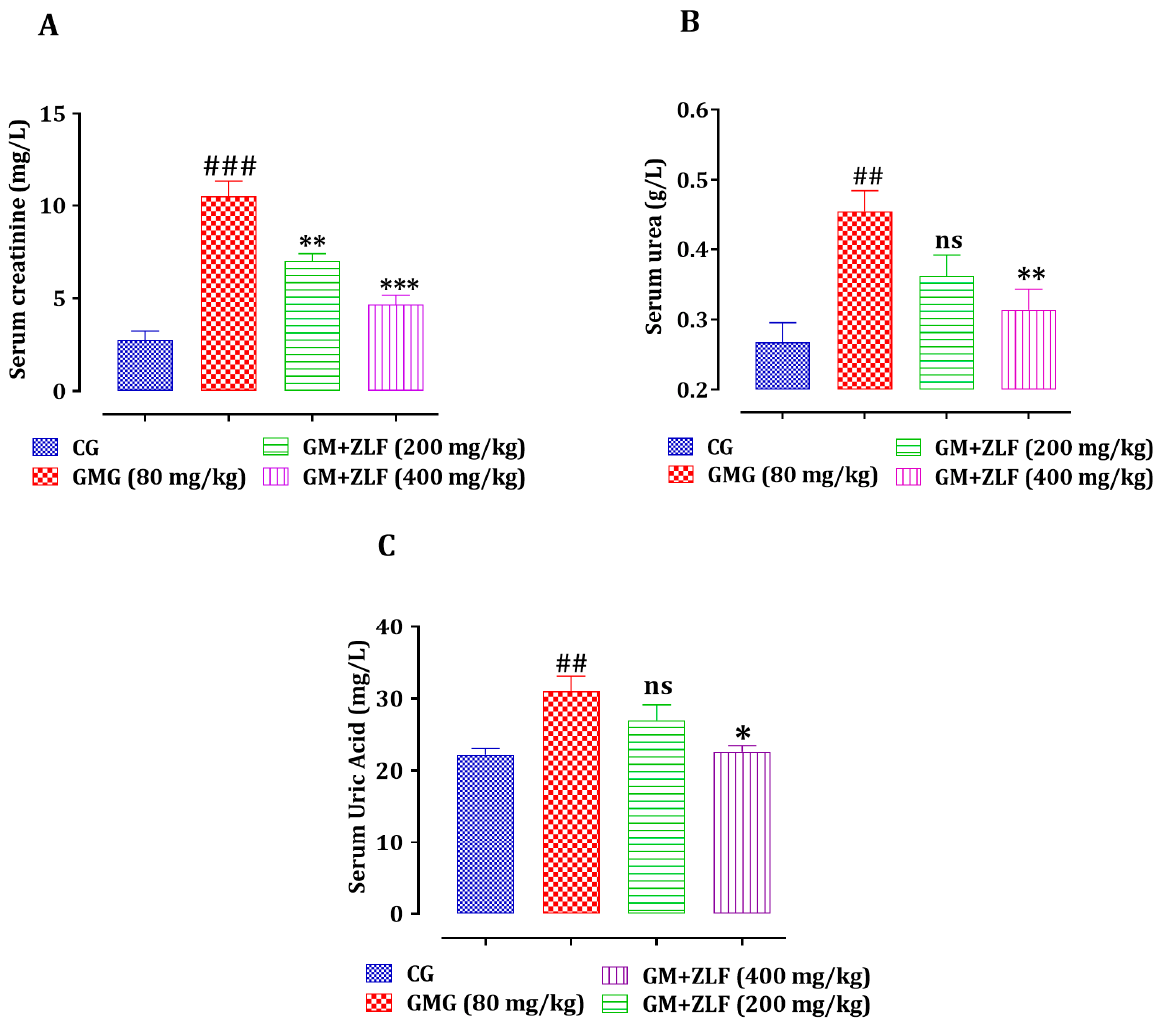
Figure 3. Effect of ZLF’s on serum creatinine ( A ), urea ( B ), and uric acid ( C ) in GM-poisoned rats. The data are presented as mean ± SEM, ( n = 6). ### p ≤ 0.001, ## p ≤ 0.01 versus CG. * p < 0.05, ** p < 0.01, *** p < 0.001 versus GMG. ns: not significant versus GMG. GM: gentamicin; CG: Control Group; GMG: GM treated Group.